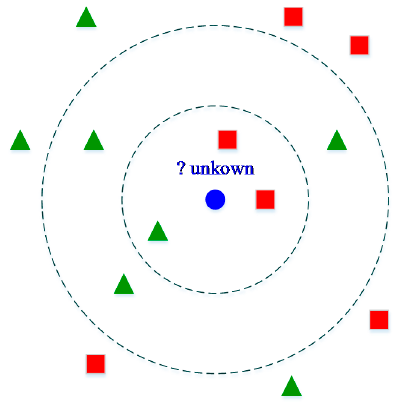
Figure 9. K-nearest neighbors algorithm (kNN) algorithm concept.